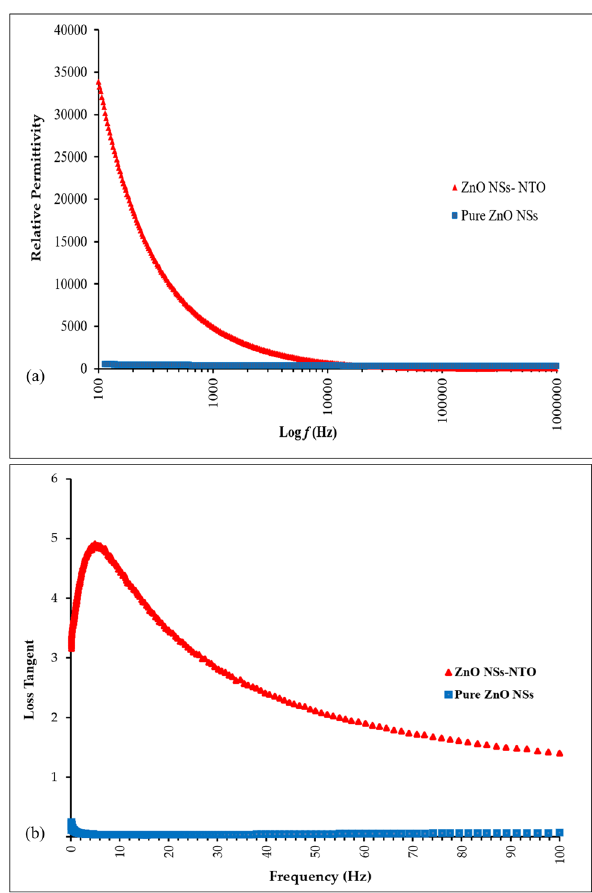
Figure 8: Physical properties of ZnO NSs – NTO and pure ZnO NSs: ( a ) dielectric constant; ( b ) loss tangent.